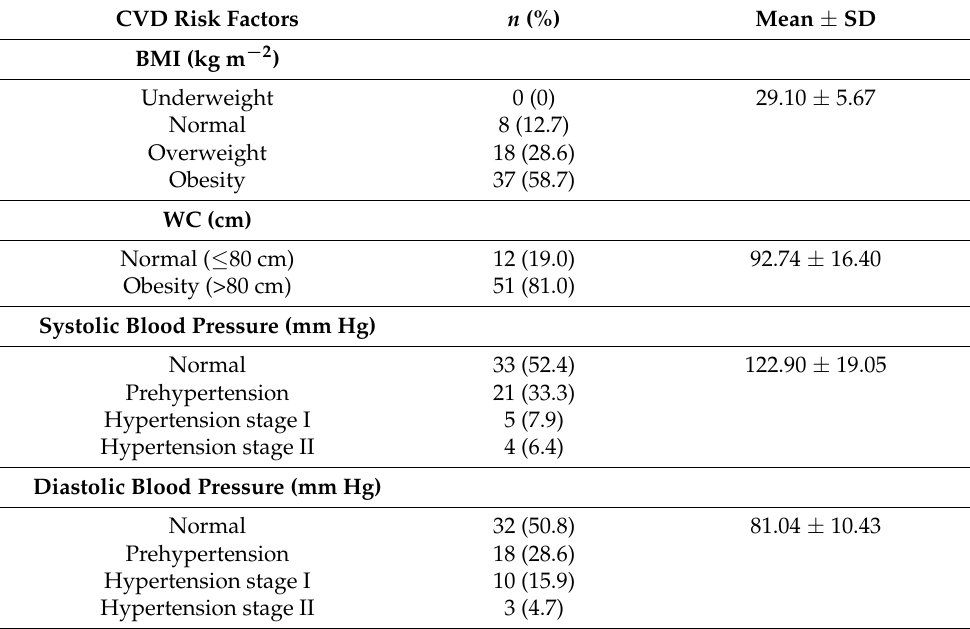
Table 2. Distribution of CVD risk factors for housewives ( n =